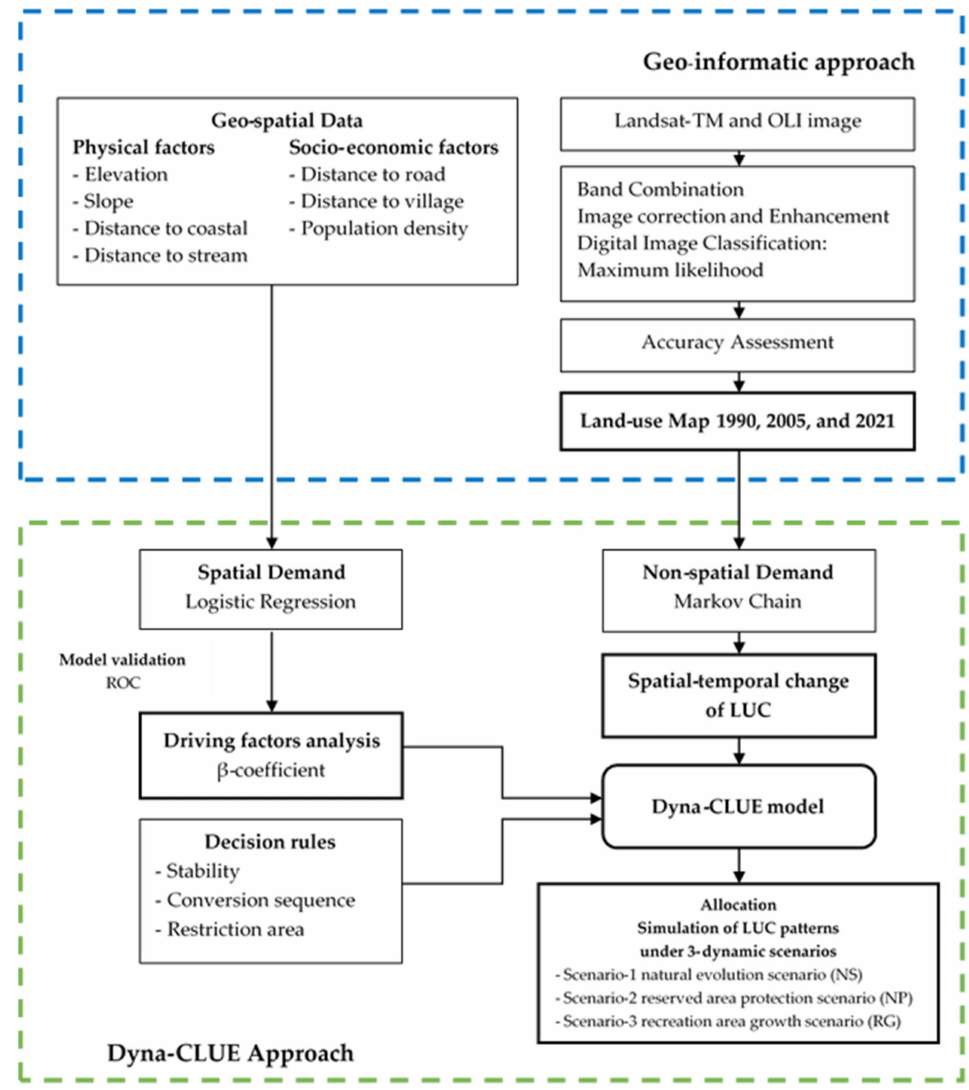
Figure 3. Flow chart of